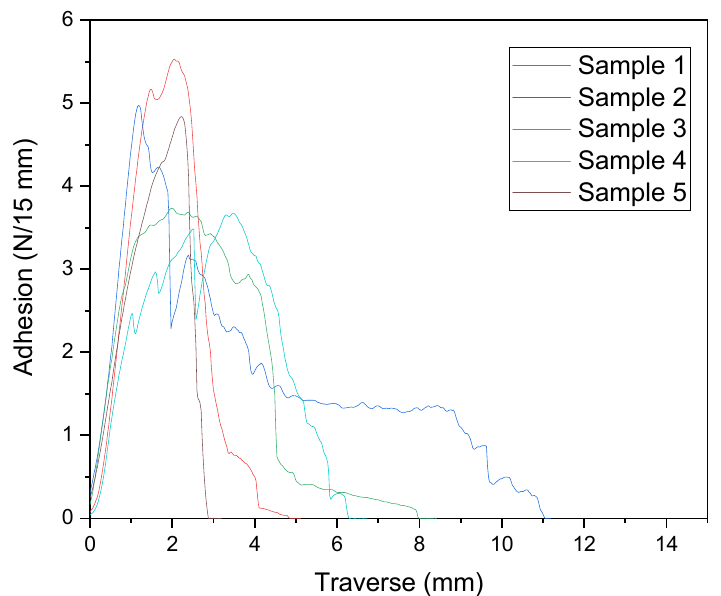
Figure 10. T-peel test results of PET//LDPE laminate after temperature exposure at 160 °C for 1 s in the sealing machine.